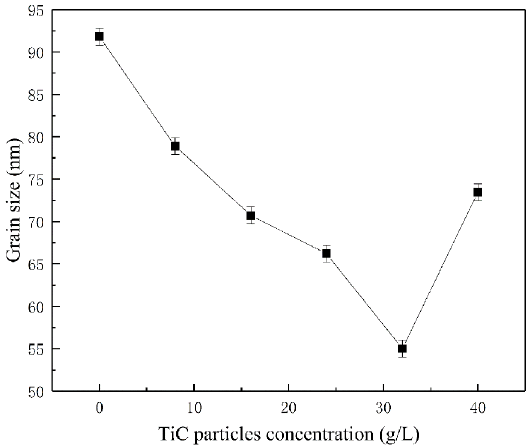
Figure 8. Effects of TiC concentration on the grain size of Ni matrix